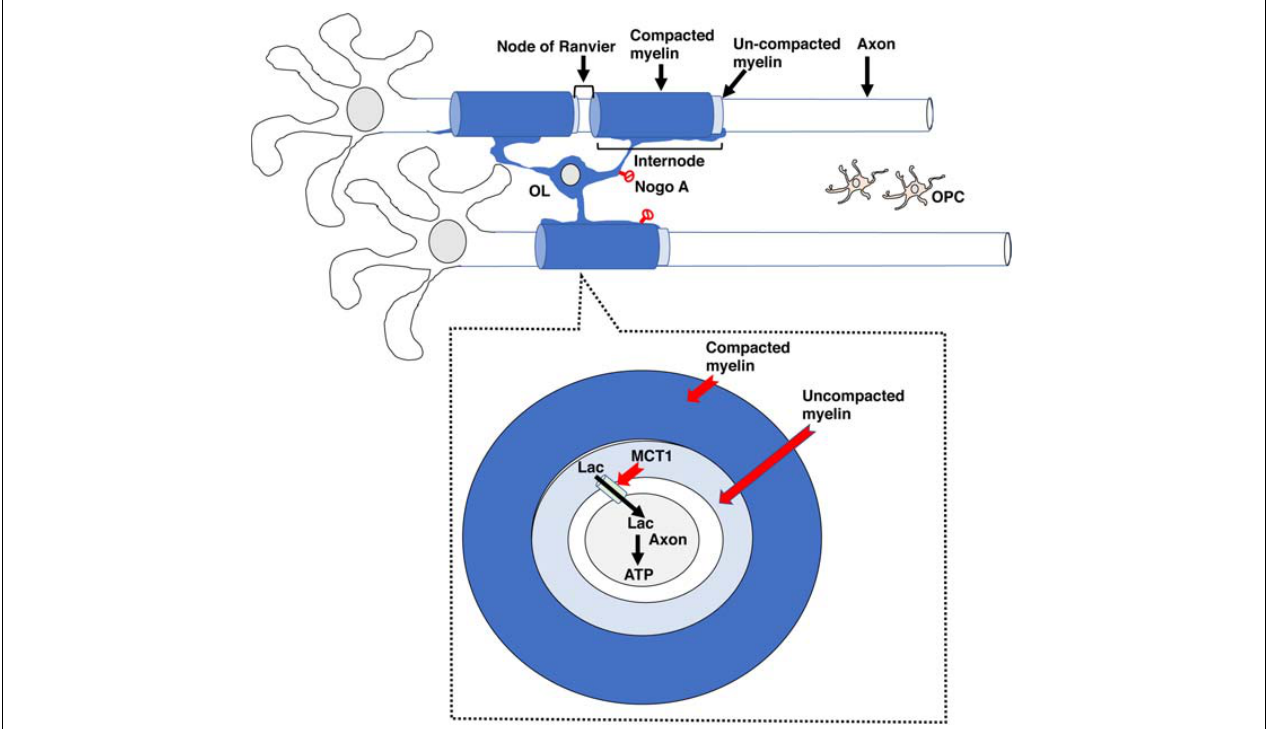
FIGURE 1 | The basic myelin components. A single oligodendrocyte can myelinate several neighboring axons by forming internodal myelin sheaths that are interspaced with myelin free zones known as nodes of Ranvier. Compacted myelin (dark blue) increases nerve conduction and prevents axonal sprouting by expressing ligands such as Nogo A (no entry red signs), whereas uncompacted myelin (light blue) provides metabolic support to underlying axonal segment by expressing channels such as MCT1. Abbreviations: OL- mature oligodendrocyte, OPC- oligodendrocyte progenitor